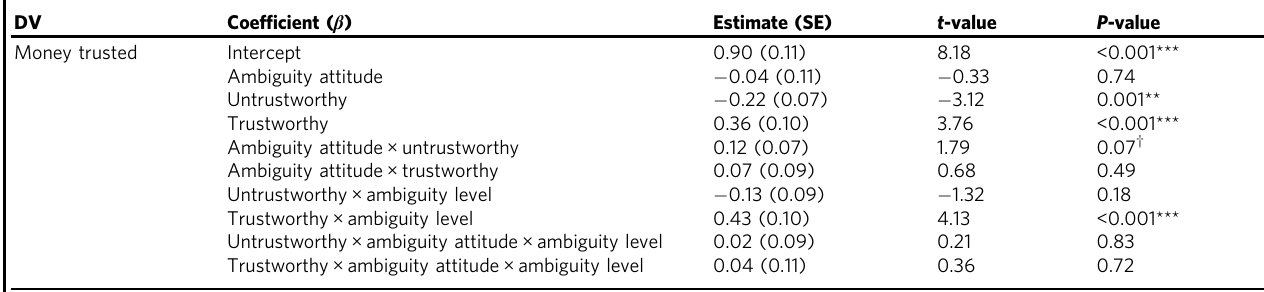
Table 3 Experiment 2: Exogenous ambiguity levels in the Trust Game DV Coef fi cient ( β